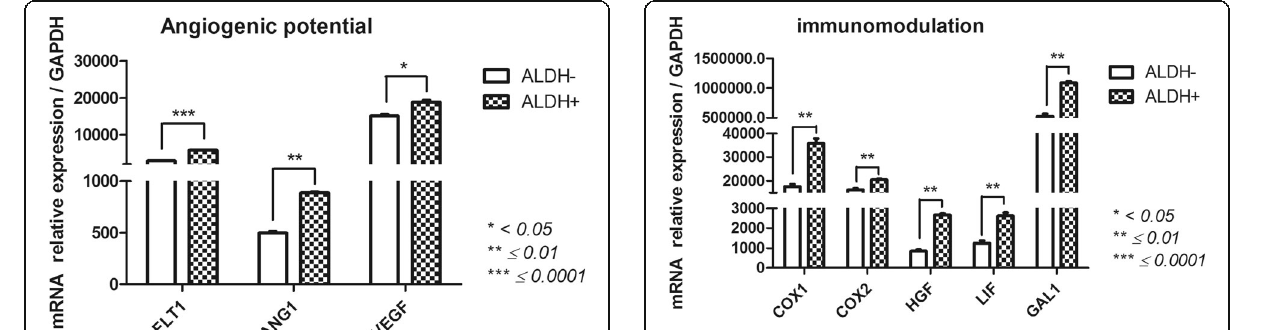
Fig. 9 Immunomodulatory-related gene expression profile of FSK-MSC subsets according to ALDH activity. After flow cytometry sorting of ALDH+ and ALDH- FSK-MSC subsets, we investigated by qPCR the expression profiles of pro-hematopoietic-associated genes COX1, COX2, HGF, LIF and GAL1 . Data are presented as mean±SEM of mRNA gene expression relative to GAPDH